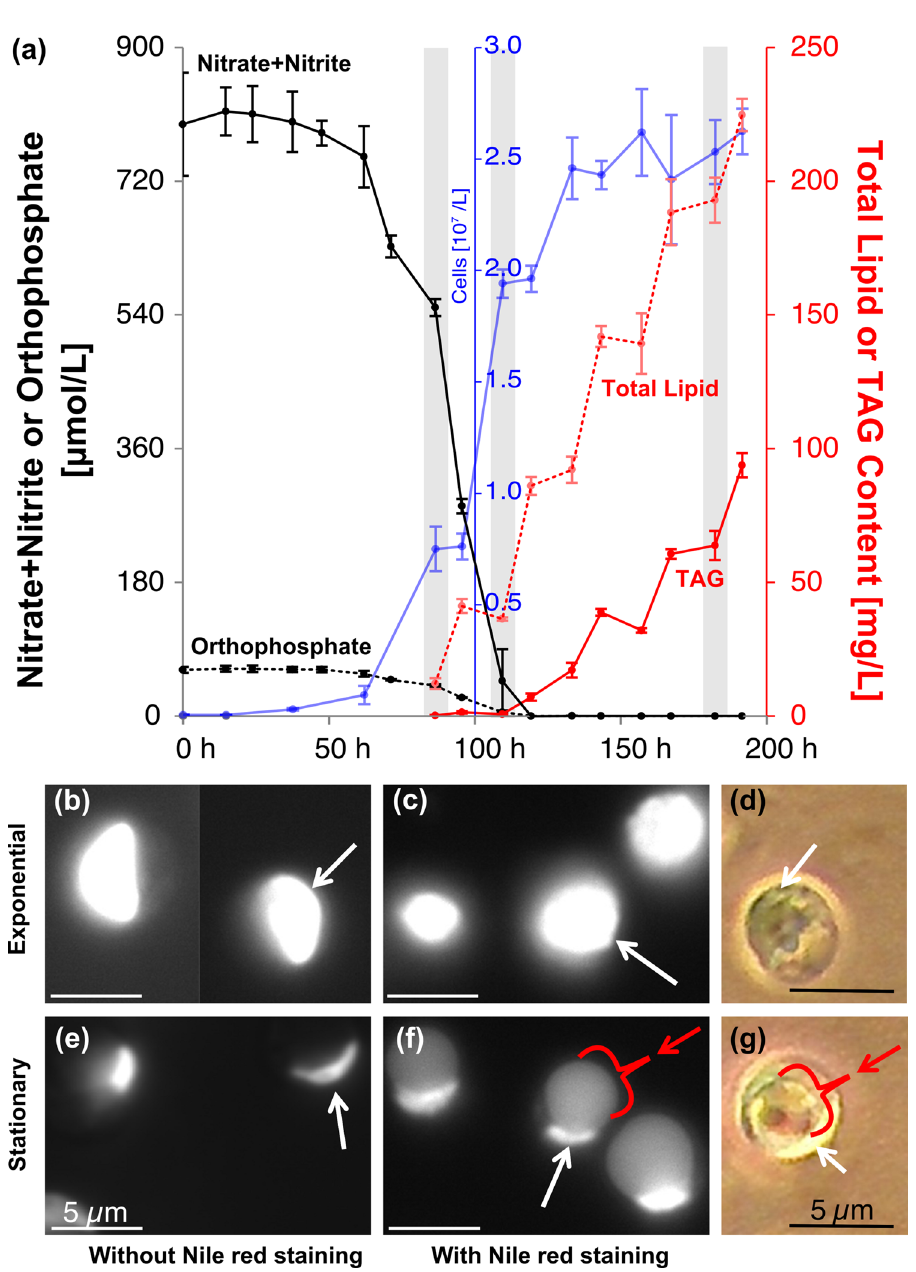
Fig 2. Lipid accumulation in Chlorella strain C596. (a) Time-course of a batch experiment culminating in N and P co-limitation (N:P = 13:1): nitrate+nitrite (black, solid), phosphate (black, dashed), cells (blue), TAG (red, solid), and total lipids (red, dashed) concentrations; error bars represent the 95% confidence interval. (b- g) Fluorescence and phase contrast microscopy of strain C596 cells grown in batch culture culminating in P limitation (N:P = 30:1). Samples were withdrawn during the exponential phase (b-d) and four days after onset of stationary (e-g) growth phase. The fluorescence microscopy reveals the chloroplast (autoflourescence, bright white) and Nile red stained lipids (in c and f; grey). The red arrows and brackets indicate intercellular TAG locations. The white arrows highlight the chloroplast.